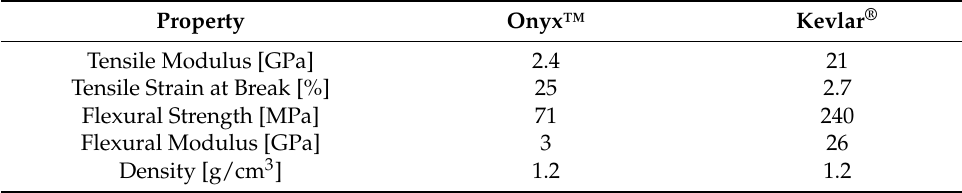
Table 1. Mechanical properties of Onyx™ filament